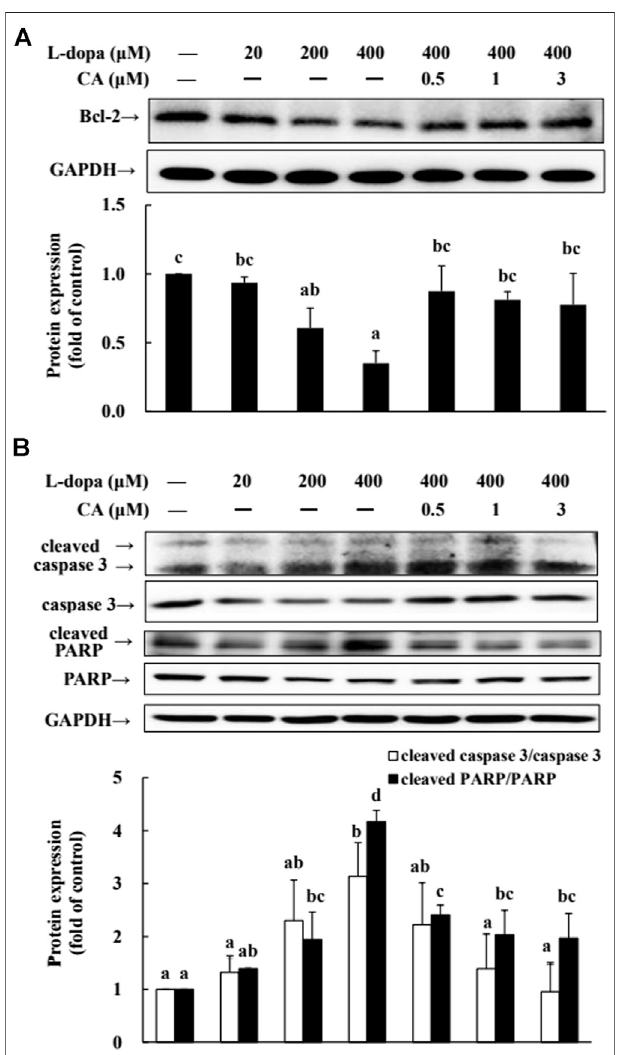
FIGURE 7 | Effect of CA on the activation of ERK1/2 and c-Jun in L -dopa-treatedSH-SY5Y cells. (A) Cells werepretreated withDMSOalone( − ) or 0.5, 1, or 3 μ M CA for 18 h and were then treated with 400 μ M L -dopa for an additional 0.5 h. One representative immunoblot out of three independent experiments isshown. (B) Thecontrolgroup wasregarded as1. Values are mean ± SD ( n (cid:1) 3). Means not sharing a common letter are signi fi cantly different, p <